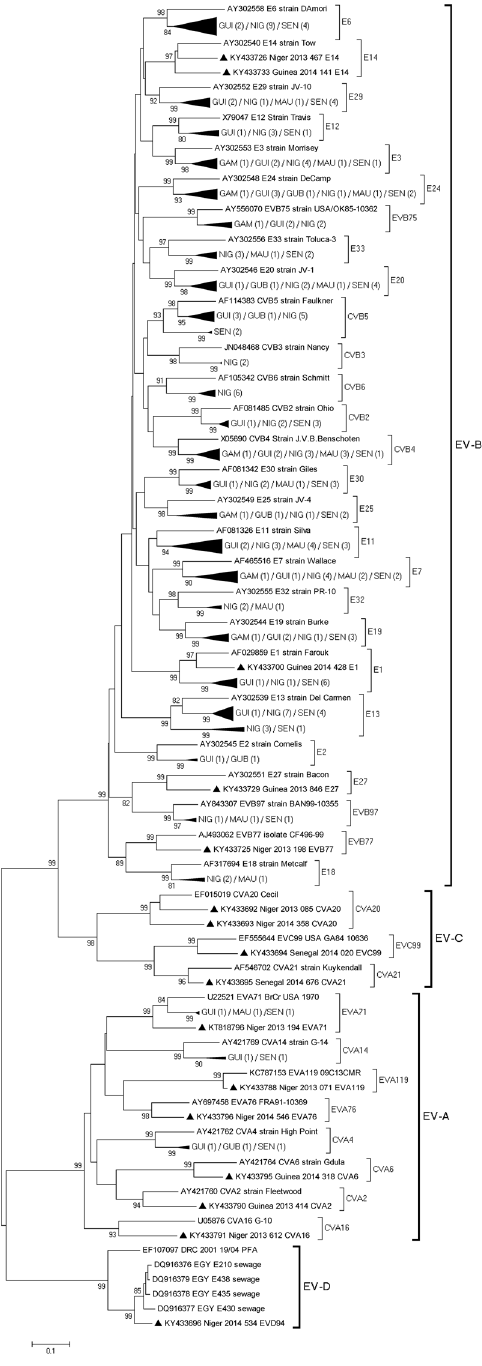
Figure 2. Phylogenetic analysis of 14 EV-A, 182 EV-B, 4 EV-C and 1 EV-D study strains and 43 international reference strains performed on ~400 bp-sized nucleotide sequence data set within the 5 ′ -VP1 region. Phylogenetic trees were inferred with a Neighbor Joining algorithm that applied Kimura 2-parameter model after excluding gaps from the alignments. The reliability of the tree topologies was estimated by bootstrap analysis with 1000 replicates. Scale is shown at the bottom as substitutions per site. Evolutionary analyses were conducted with MEGA5 software. Study strains are indicated with black triangles. Study strains are indicated by the GenBank accession number, country, year of isolation and the internal laboratory code that corresponds to the serial number of the AFP case. Numbers in brackets indicate the number of study strains in the sub-cluster. SEN Senegal; MAU Mauritania; GAM Gambia; GUI Guinea Conakry; GUB Guinea Bissau; NIG